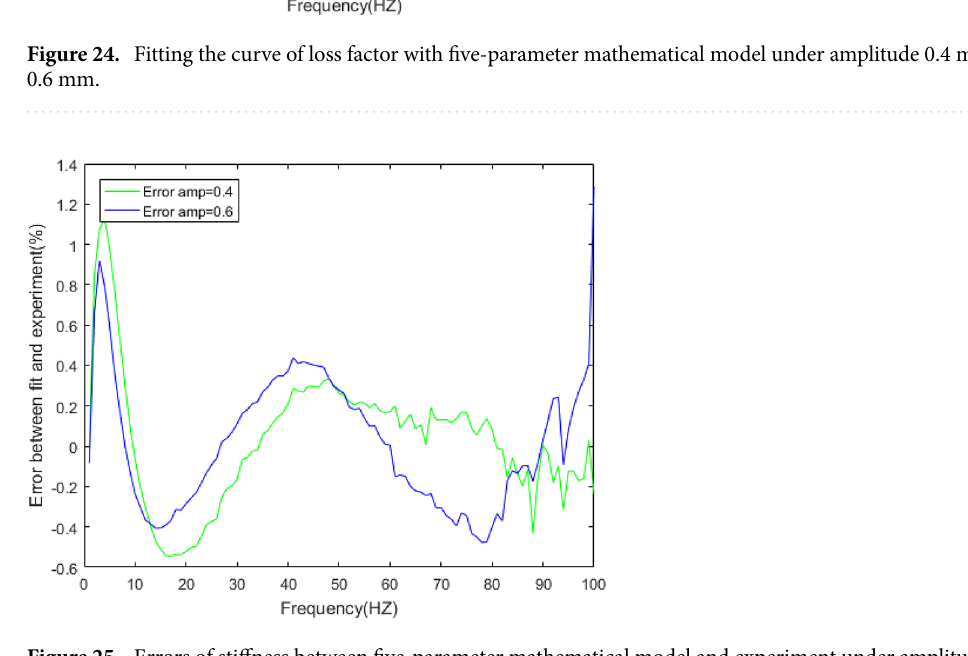
Figure 25. Errors of stiffness between five-parameter mathematical model and experiment under amplitude 0.4 mm, 0.6